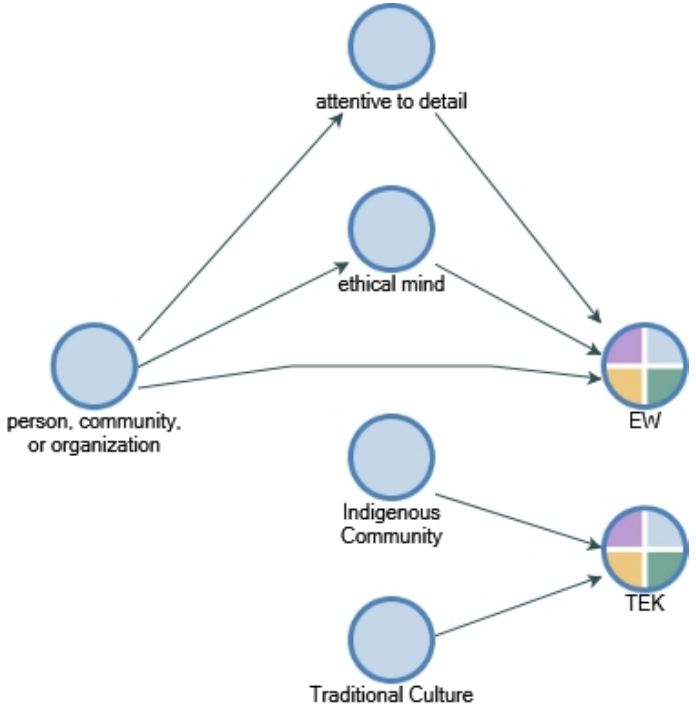
Figure 6. The comparison diagram of agents between TEK and EW.